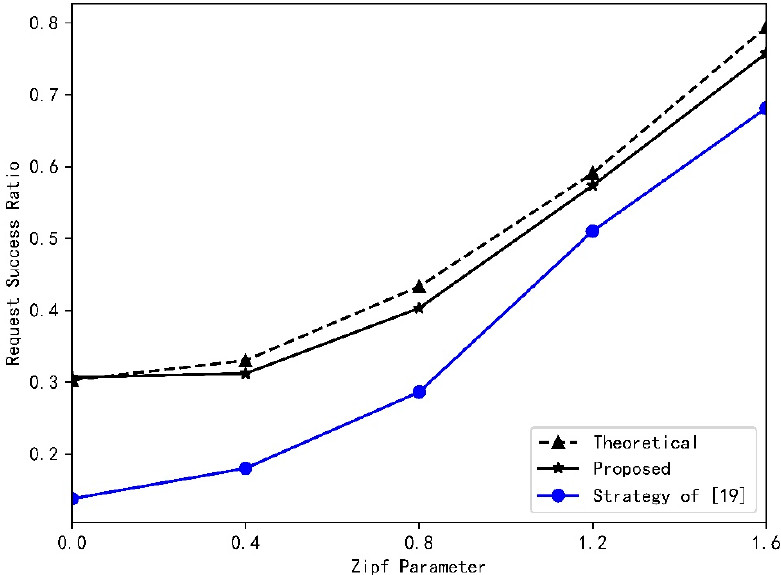
Figure 12. The relationship between Request Success Ratio and Zipf distribution parameter.